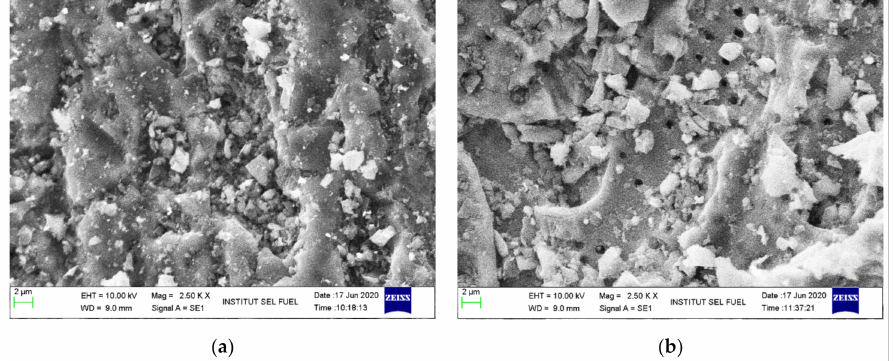
Figure 11. SEM analysis of exhausted ZnAc 2 /CAC adsorbent: ( a ) ZnAc 2 /CAC_O (E) and ( b ) ZnAc 2 /CAC_N (E) at 2.5 k × (10 µ m).